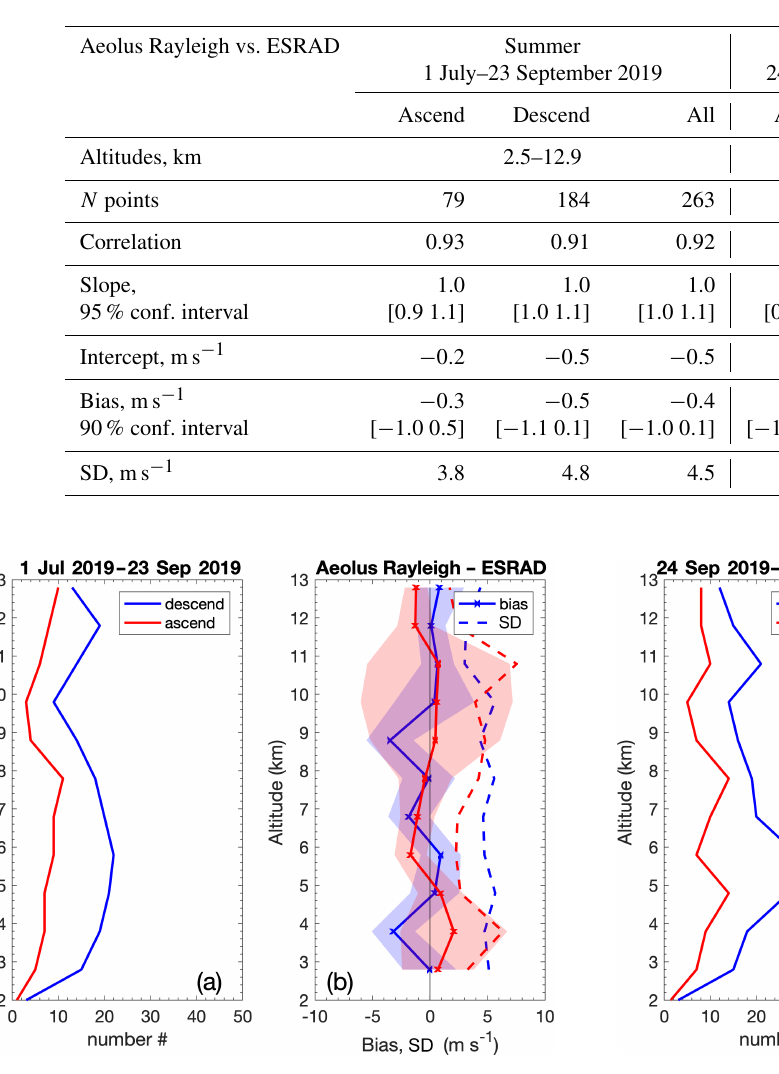
Figure 11. Height profiles in 1km bins of (a) the number of com- parison points available and (b) mean value (bias) and standard de- viation of the differences between Aeolus Rayleigh HLOS winds and ESRAD-derived HLOS winds for the Arctic summer period 1 July–23 September 2019. Red lines and shading are for ascending tracks and blue is for descending ones. Solid lines in (b) show the bias, with the shaded areas corresponding to the 90% confidence interval. Dashed lines in (b) show the standard deviation.